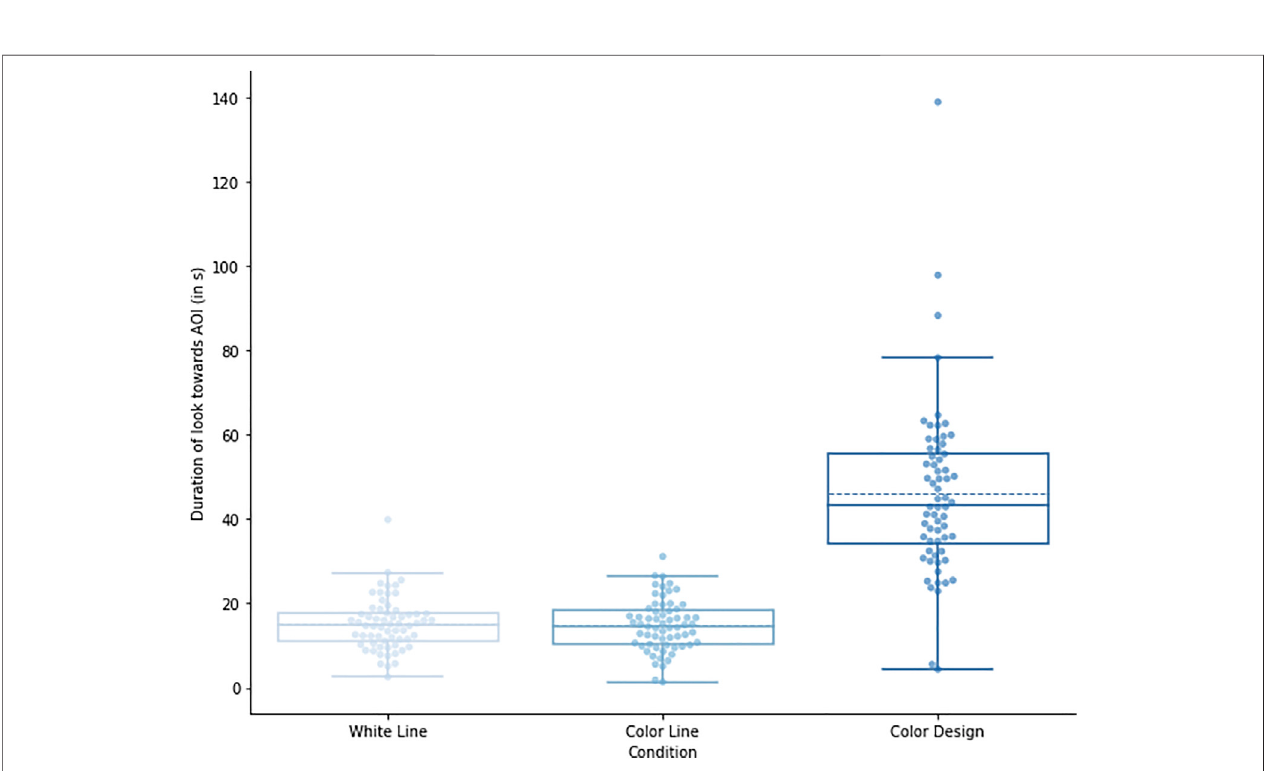
FIGURE 11 | Bar charts illustrating the impact of Environment (Concrete vs . Vegetation) on the duration of gaze fi xations to the areas of interest (AIO) during spontaneous walking in the six urban virtual environments.